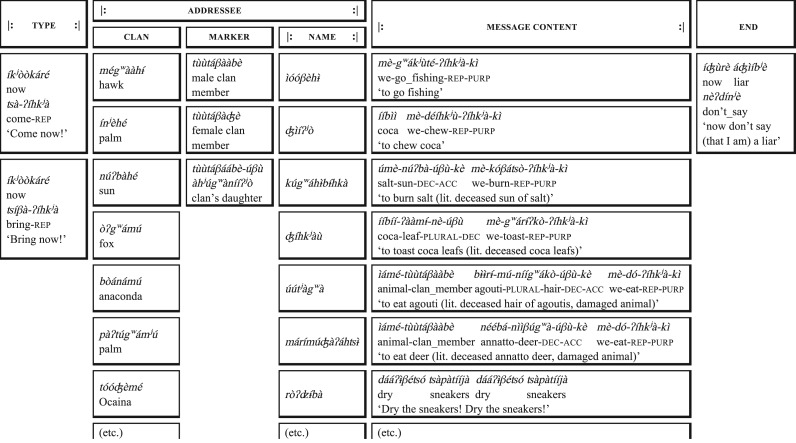
The structure of manguaré ‘calling messages’. Segmentation into meaningful elements and translation of each of them, in addition to idiomatic translations, are provided. Abbreviations: rep: repetitive; purp: purposive; dec: deceased; acc: accusative case.